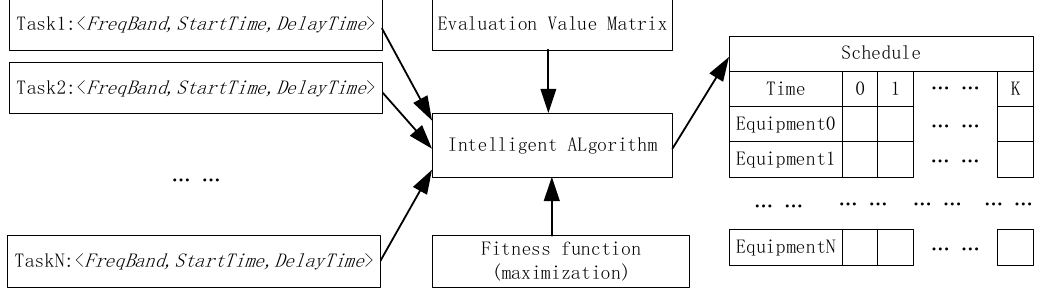
Figure 1. Model framework of DSTT.